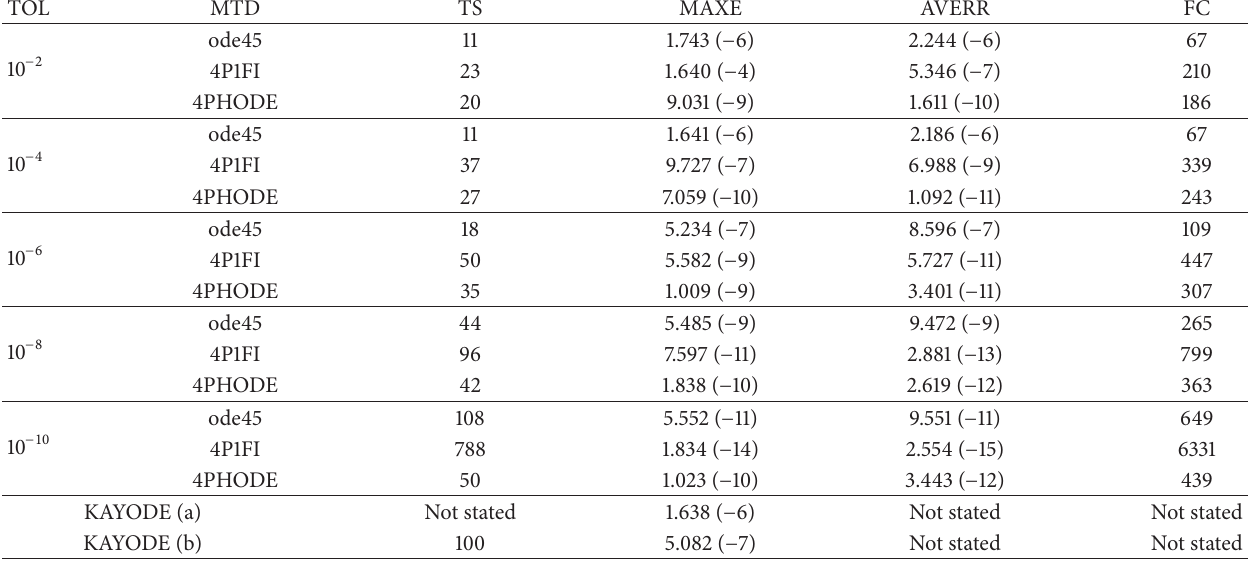
Table 1: Numerical results for solving Problem